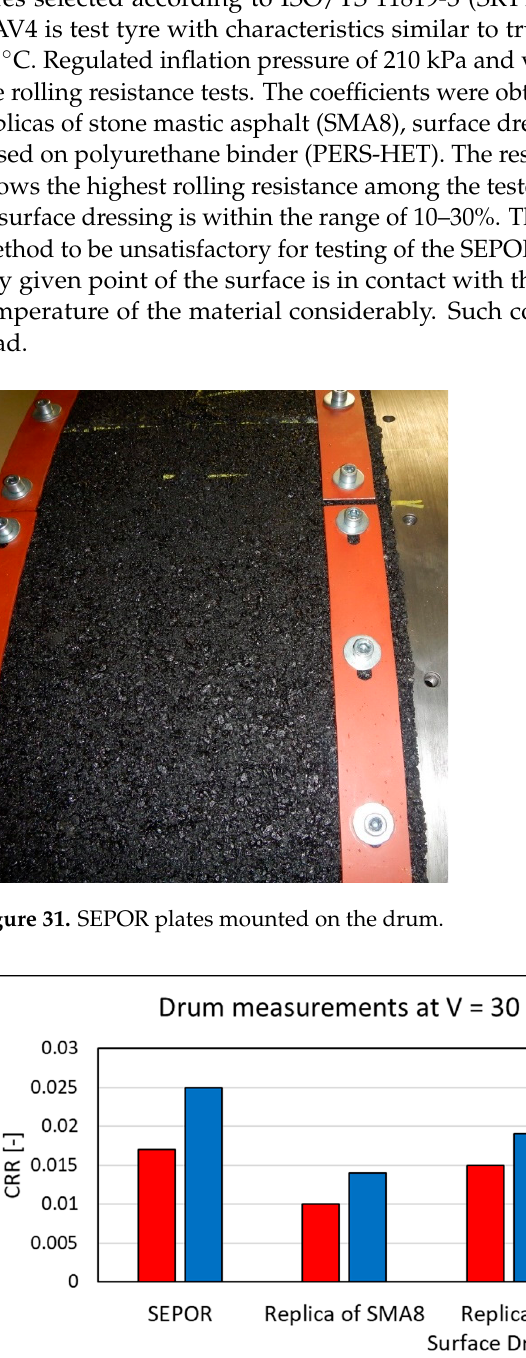
Figure 33. Coefficients of rolling resistance measured on the road at 80 km/h at different ambient temperatures. 7. Fire Hazard One of the primary features of poroelastic pavements is their very positive effect on the suppression of spilled fuel fires. These features were noticed already during the im- plementation of the 7PRUE PERSUADE project in relation to poroelastic surfaces pro- duced with polyurethane binder. As the pavements developed under the SEPOR project were based on bituminous binder, it was necessary to verify whether these pavements also exhibited advantageous fire suppression properties. Fires of engine fuel spills under the chassis of a passenger car were investigated. In order to carry out the tests, four Opel Corsa passenger cars (withdrawn from traffic) were purchased. Four test pads were prepared and covered with the following pavements: •